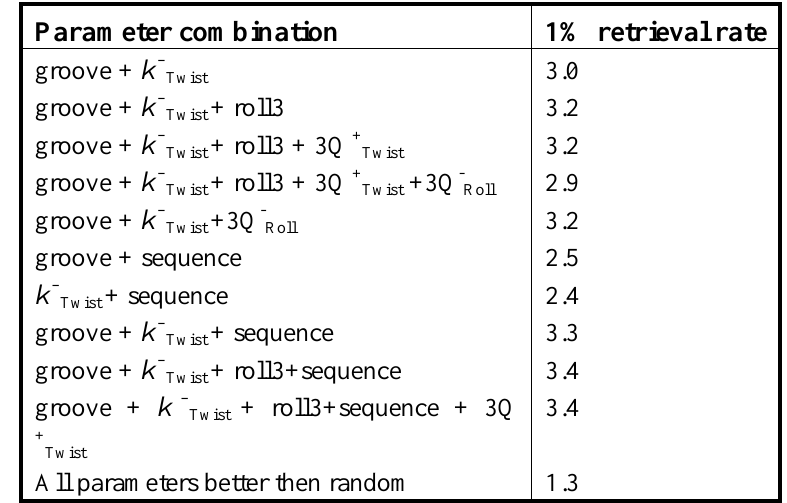
Table 3. Data fusion retrieval rate. 1% retrieval rate is the mean number of Sp1 tfbs found amongst the top 1% of the chromosome blocks.